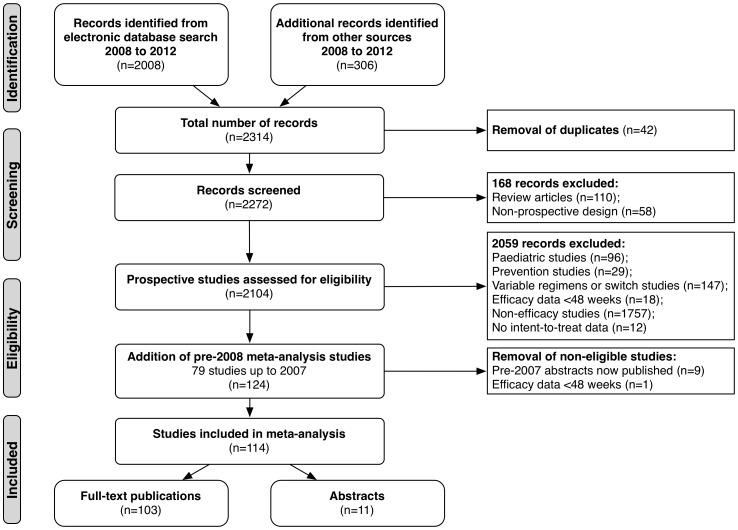
PRISMA statement 2009 flow chart.Diagram depicts each step of the study selection process undertaken in this systematic review and meta-analysis, including the reasons for exclusion.